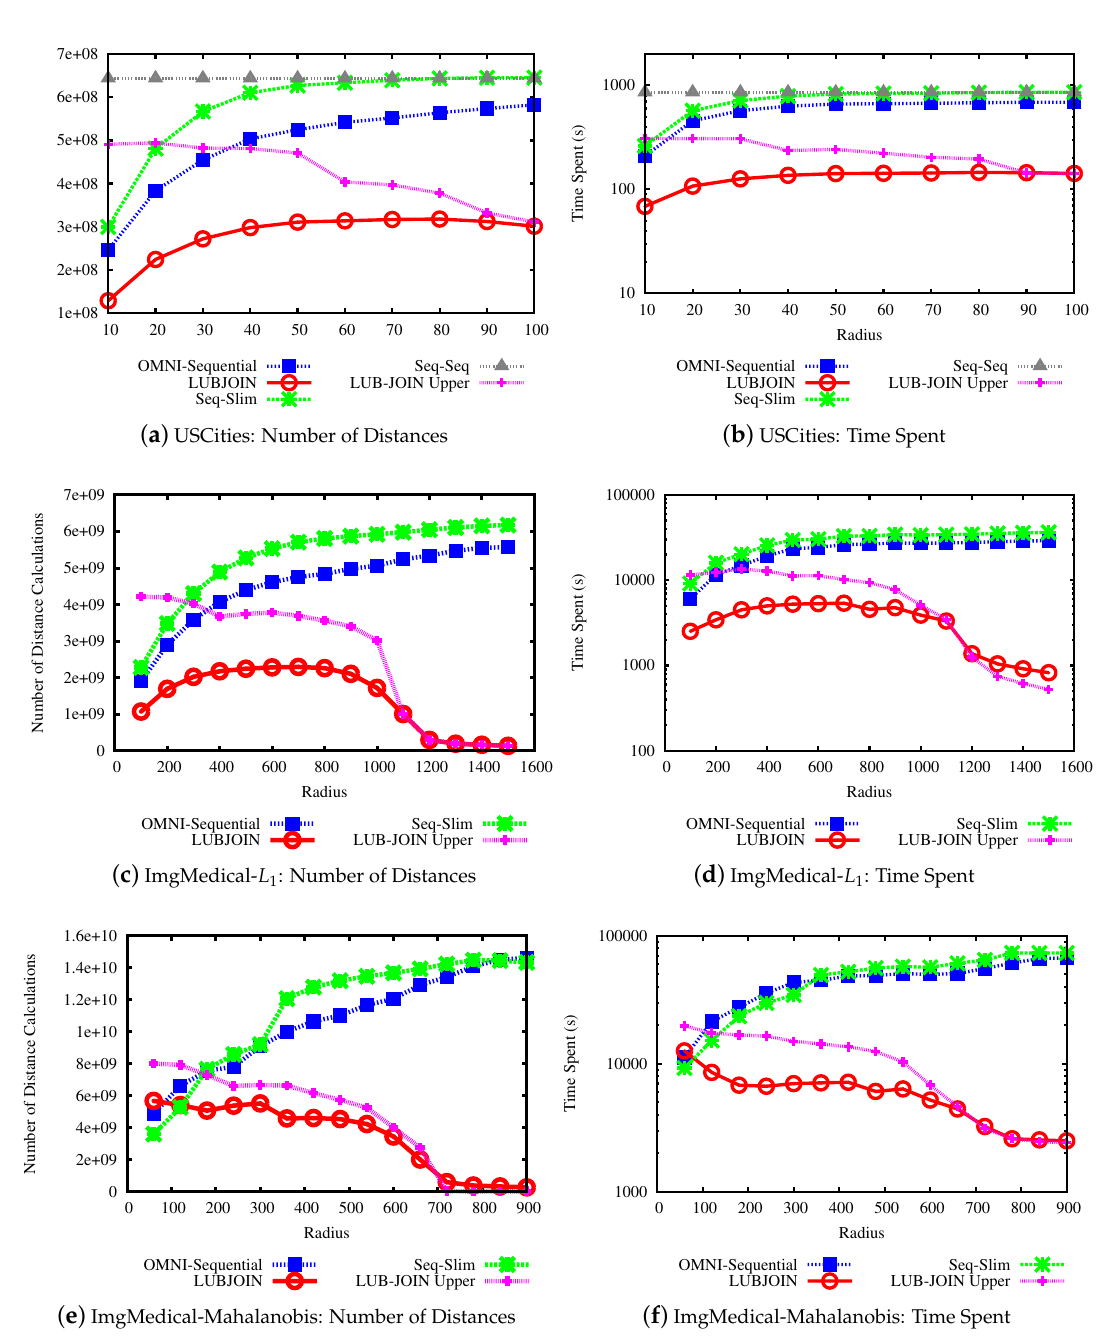
Figure 10. Performance of similarity joins for LUBJOIN. ( a , c , e ) the average of the number of distances calculated in queries. ( b , d , f ) the time spent for performing the queries